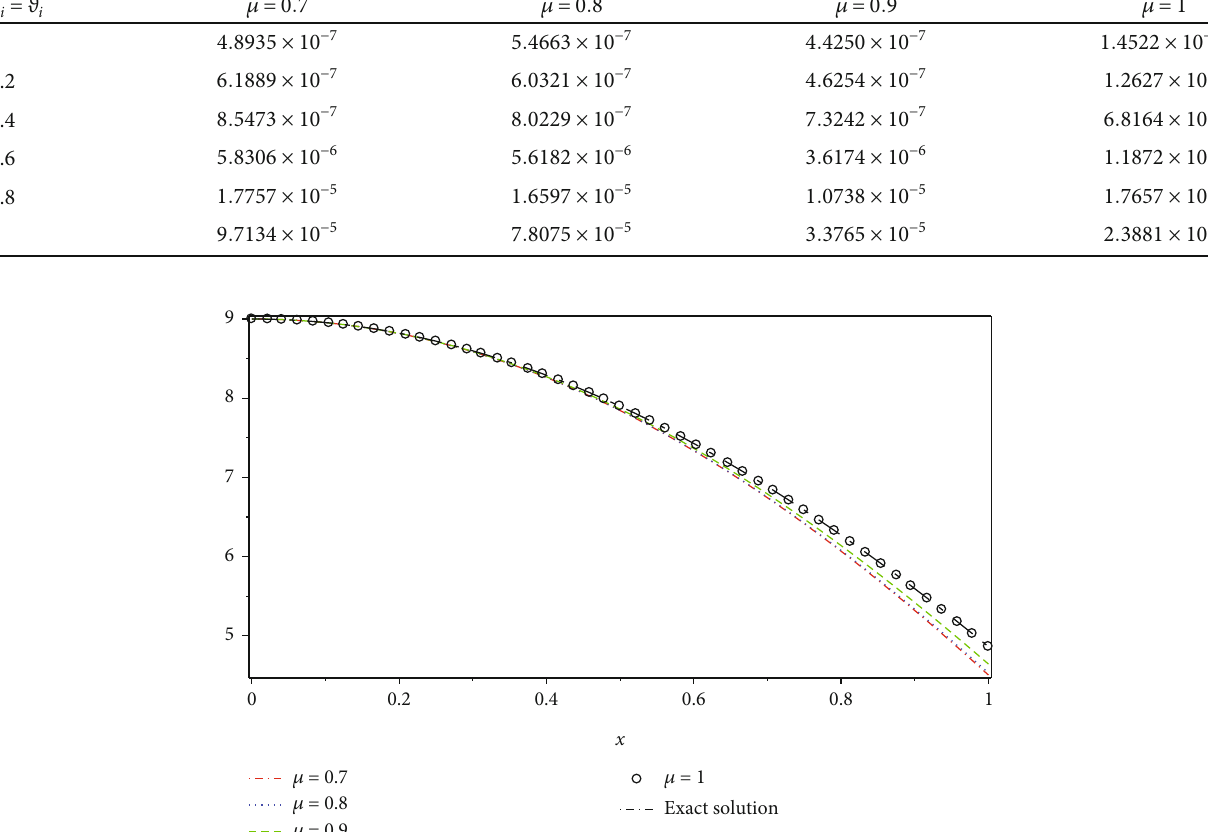
, M 1 2 for Example 1.